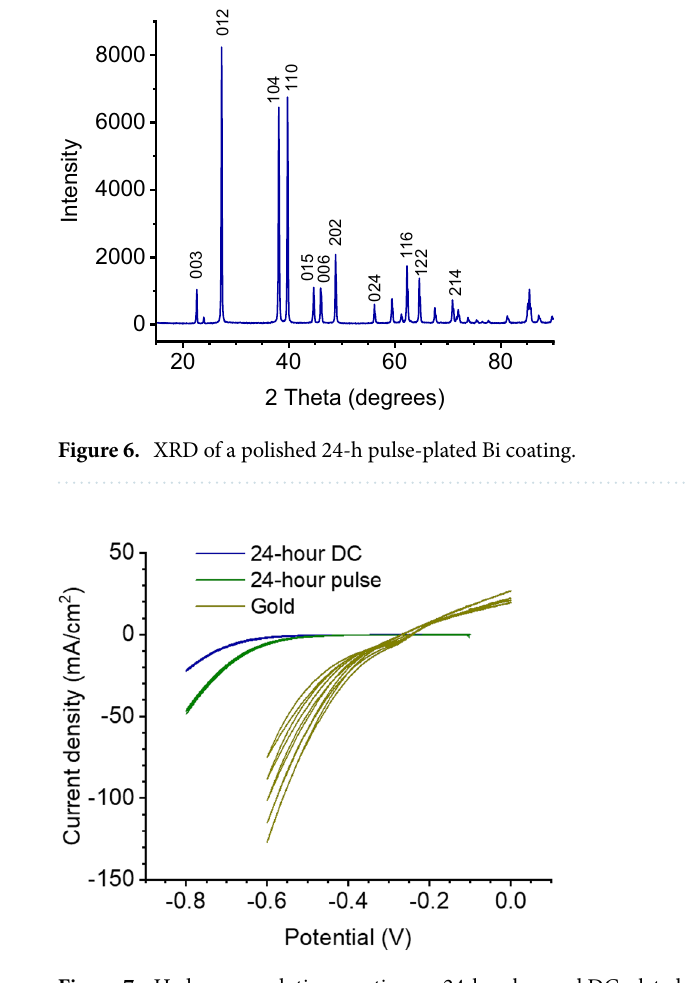
Figure 7. Hydrogen evolution reaction on 24-h pulse- and DC-plated bismuth compared to gold. Cyclic voltammetry performed at 20 mV/s in 10% HNO 3 using a standard calomel reference electrode (saturated KCL) and a carbon rod counter